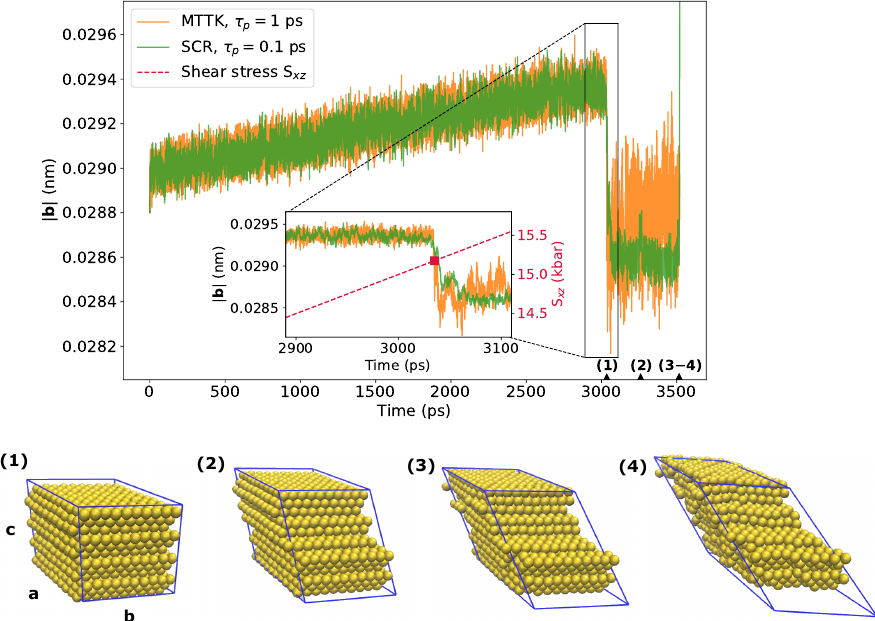
Figure 10. Results from the simulations of the gold crystal systems in LAMMPS, employing the MTTK and SCR anisotropic barostats in presence of a linearly increasing shear stress. The plot shows the trajectory for the modulus of the cell vector b , which is a good variable to describe the crystal breaking. Selected structures are shown with the corresponding sampling times along the horizontal